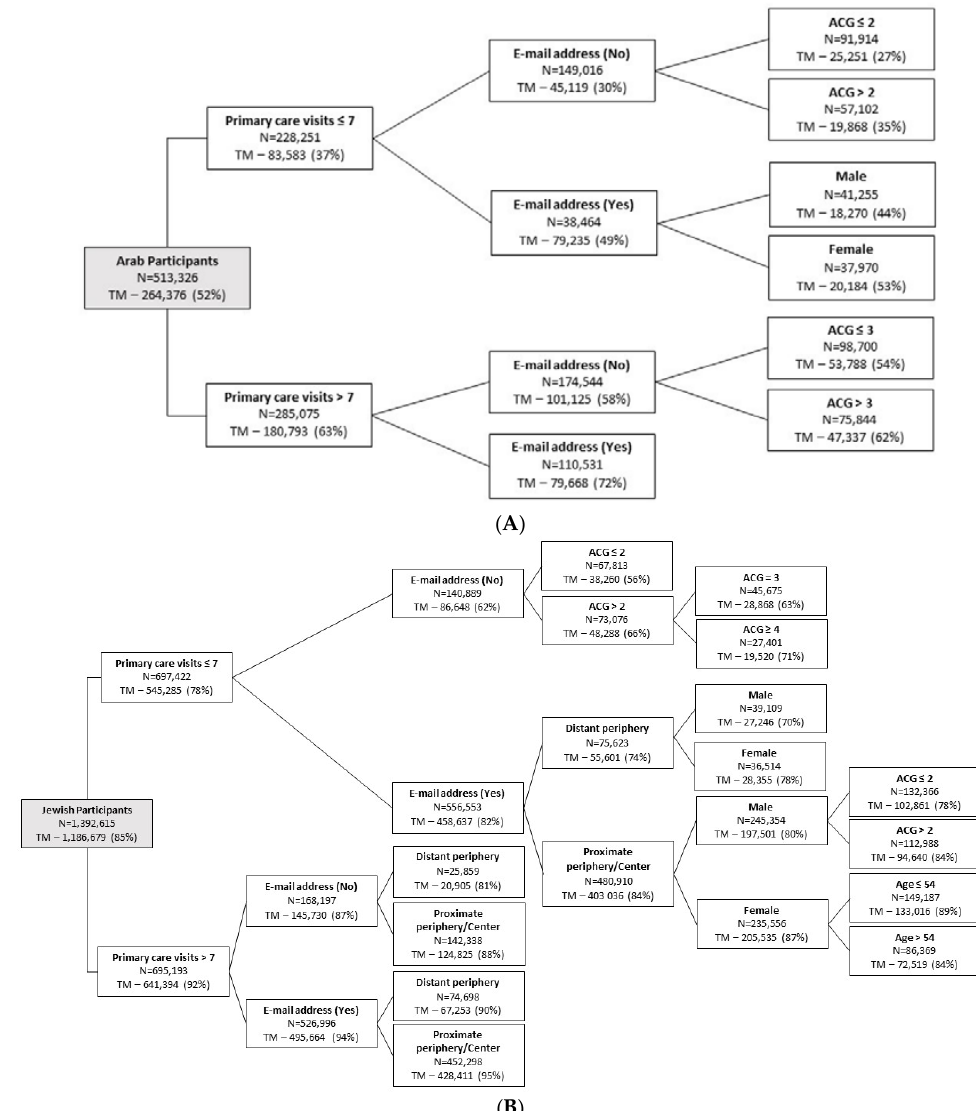
Figure 1. Classification tree analysis for utilization of telemedicine during the COVID-19 pandemic. ( A ) Arab participants; ( B ) Jewish participants.